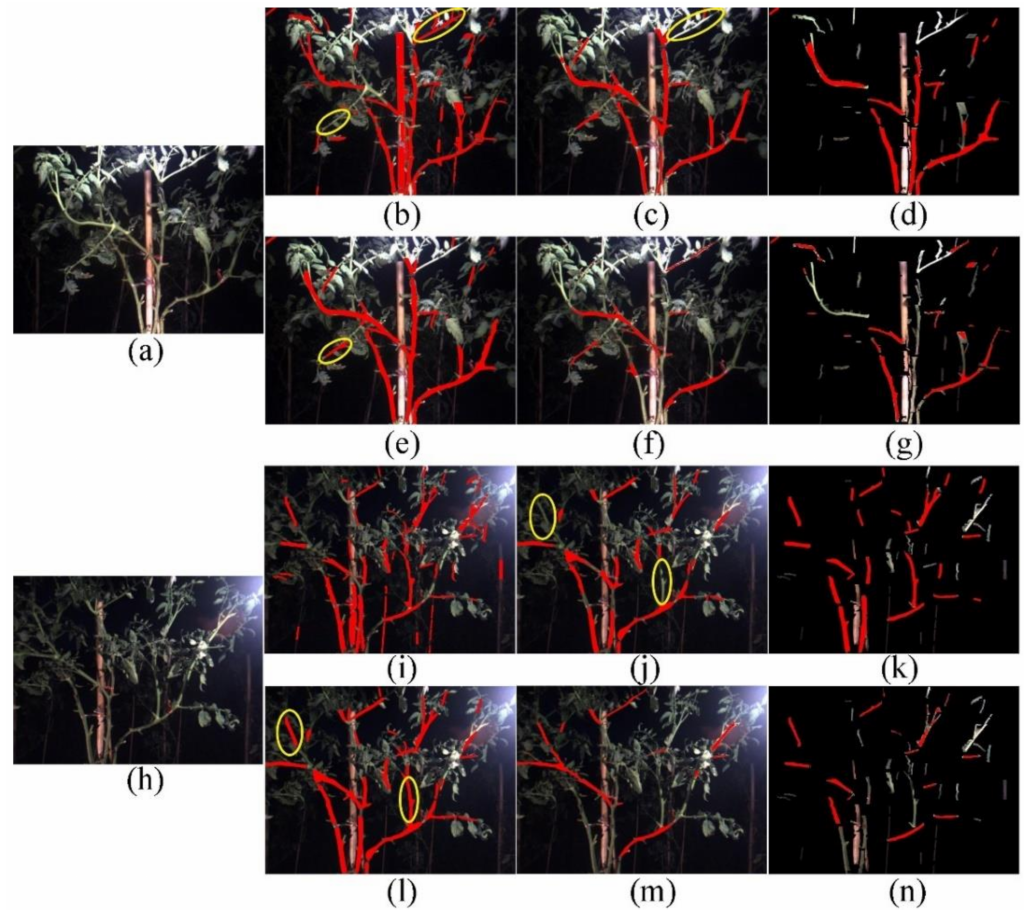
Figure 8. Performance comparison among four algorithms: ( a ) raw image 1; ( b ) result 1 using DEM; ( c ) result 1 using Mask R-CNN; ( d ) result 1 using cascaded neural network composed of DEM